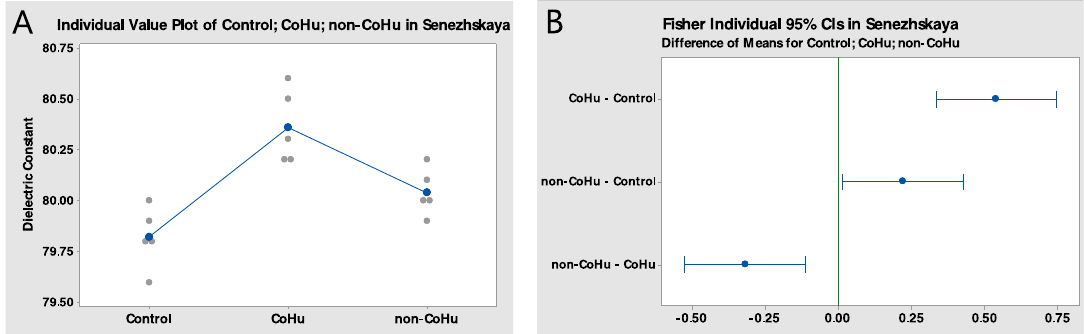
Figure 5. ( A ) Senezhskaya water dielectric constant scattered data in samples treated with CoHu and non-CoHu. ( B ) Fisher pairwise comparisons for dielectric constant measurements in Senezhskaya natural water. CIs are confidence intervals. If an interval does not contain zero, the corresponding means are significantly different.